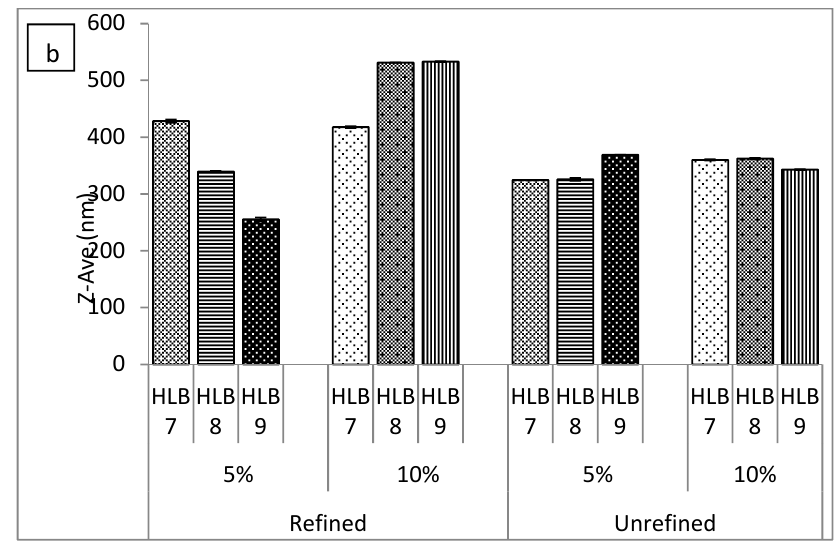
Figure 1. Effect of oil type (refined vs. unrefined), hydrophilic lipophilic balance (HLB), and surfactant concentration on the particle size of emulsions prepared by ( a ) high-energy method and ( b ) low-energy method. Tween 85/Span 85 ratios in the emulsions were 1.30 (HLB 7), 2.07 (HLB 8), and 3.60 (HLB 9).